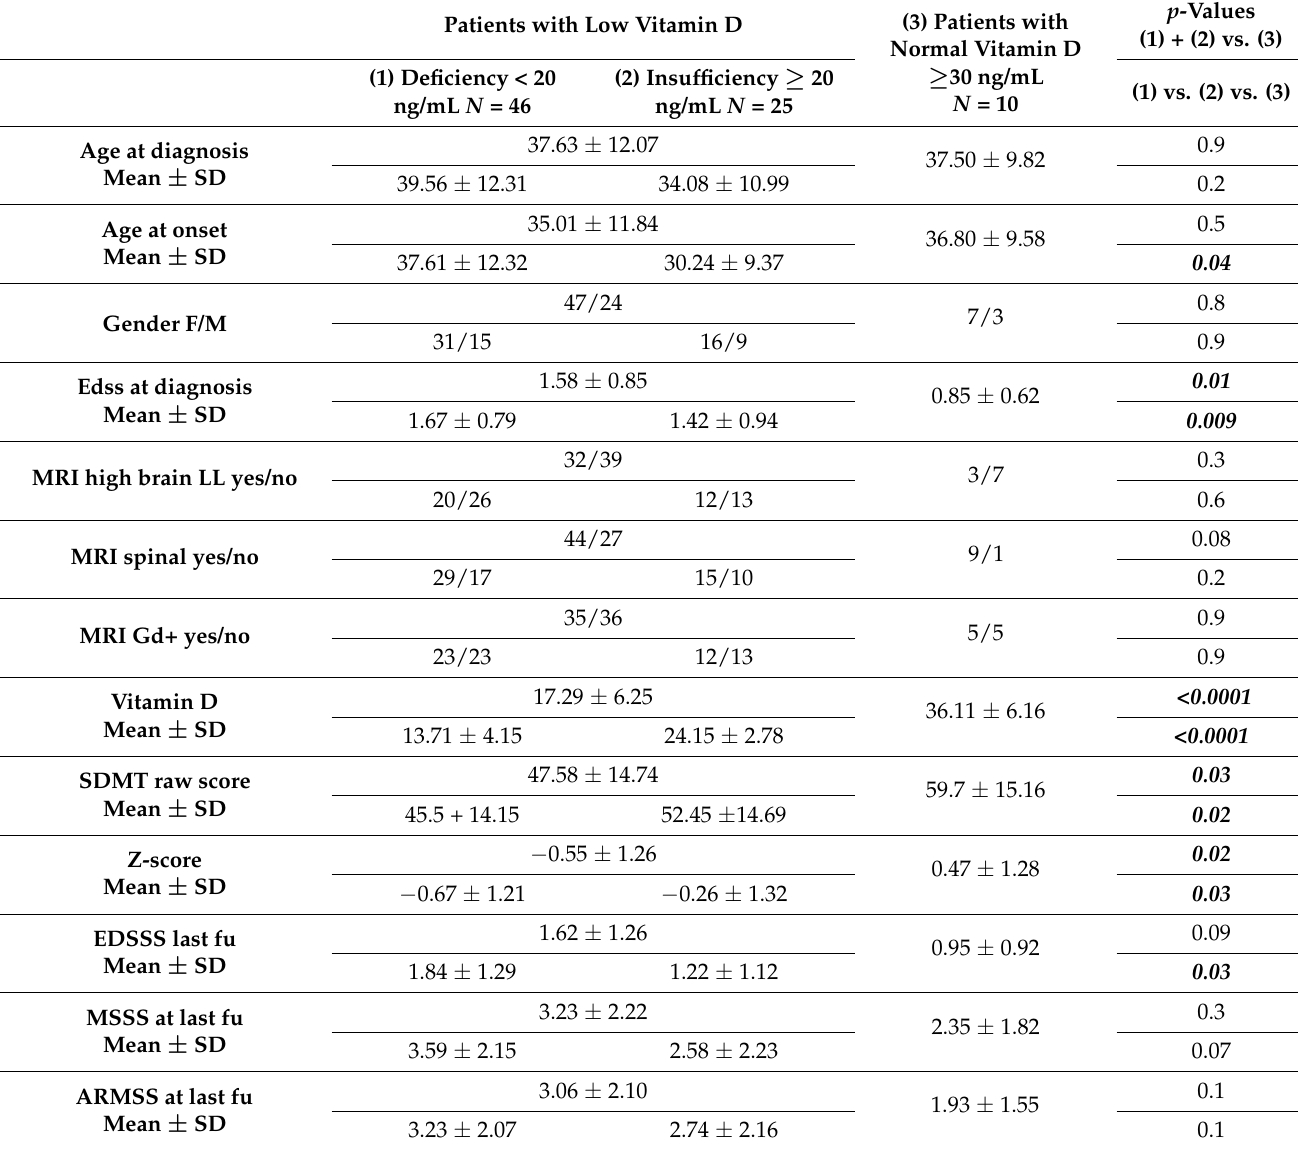
Table 1. Between-group differences in vitamin D levels and demographic, clinical, and radiological characteristics ( N = 81). Patients with Low Vitamin D (3) Patients with Normal Vitamin D